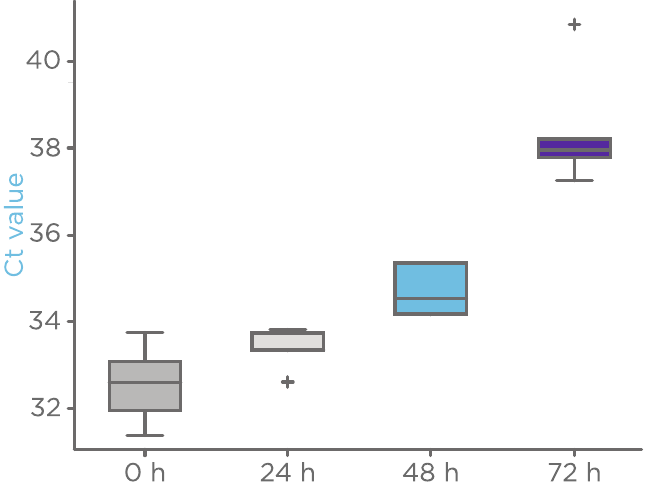
Figure 4. The stable half-life of inactivated SARS-CoV-2 on filters was close to 48 h. Virus samples aerosolized onto filters pre-exposed to breath for 30 min displayed an increase in Ct values from time 0 to 48 h that markedly increased between 48 and 72 h. There were 6 replicates per time point. Wilcoxon rank sum testing between time point 0 and time 24 h, 48 h and 72 h led to p-values of 0.25, 0.006 and 0.002 after correction for multiple testing, respectively. Filters not pre-exposed to breath showed similar stability (Supplementary Fig. 3).